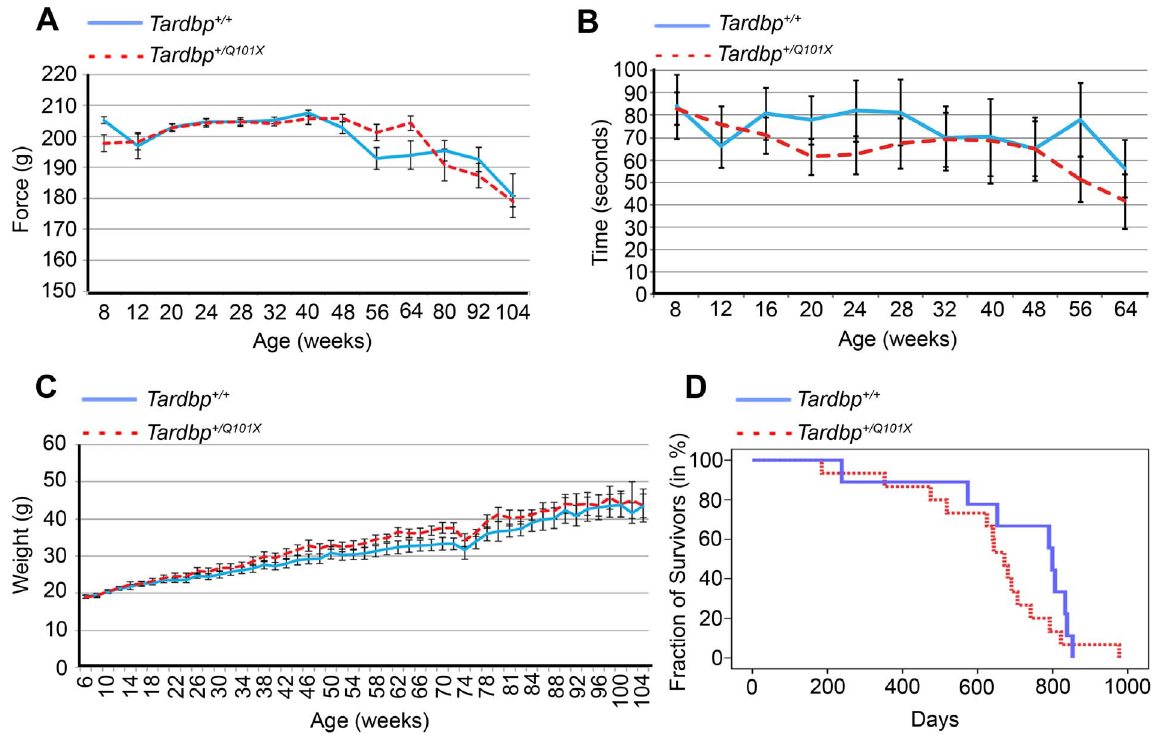
Figure 3. Grip-strength, locomotion, body weight, survival of Tardbp + /Q101X mice. ( A ) Grip-strength of female Tardbp + /Q101X mice is not significantly different from that of Tardbp + / + mice. Measurements represent average force (grams) in duplicate over all four limbs. Data are mean 6 SEM. Tardbp + / + n=9, Tardbp + /Q101X n=15. ( B ) Rotarod performance of female Tardbp + /Q101X mice is not significantly different from that of female Tardbp + / + mice. Measurements are time (seconds) on the accelerating rotarod averaged from 9 trials over 3 days. Data are mean 6 SEM. Tardbp + / + n=13, Tardbp + /Q101X n=15. ( C ) No significant differences in bodyweight of Tardbp + / + and Tardbp + /Q101X female mice. Bodyweight was recorded every two weeks. Tardbp + / + n=9, Tardbp + /Q101X n=15. Data are mean 6 SEM. ( D ) The Q101X mutation does not affect survival of female mice. Kaplan-Meier survival plot showing survival, Tardbp + / + n=9 survival=709 6 66 days, Tardbp + /Q101X n=15, survival=634 6 49 days (p=0.235).